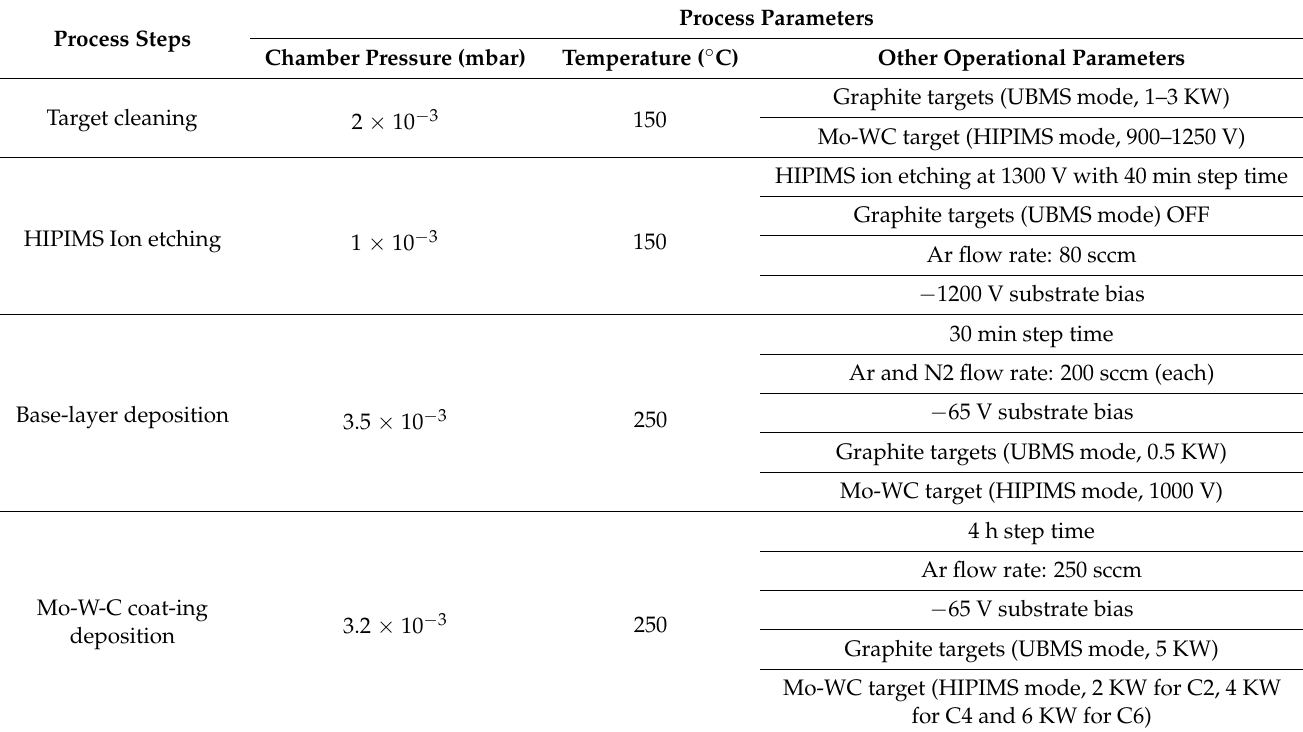
Table 1. Deposition of C2, C4 and C6—process steps and related